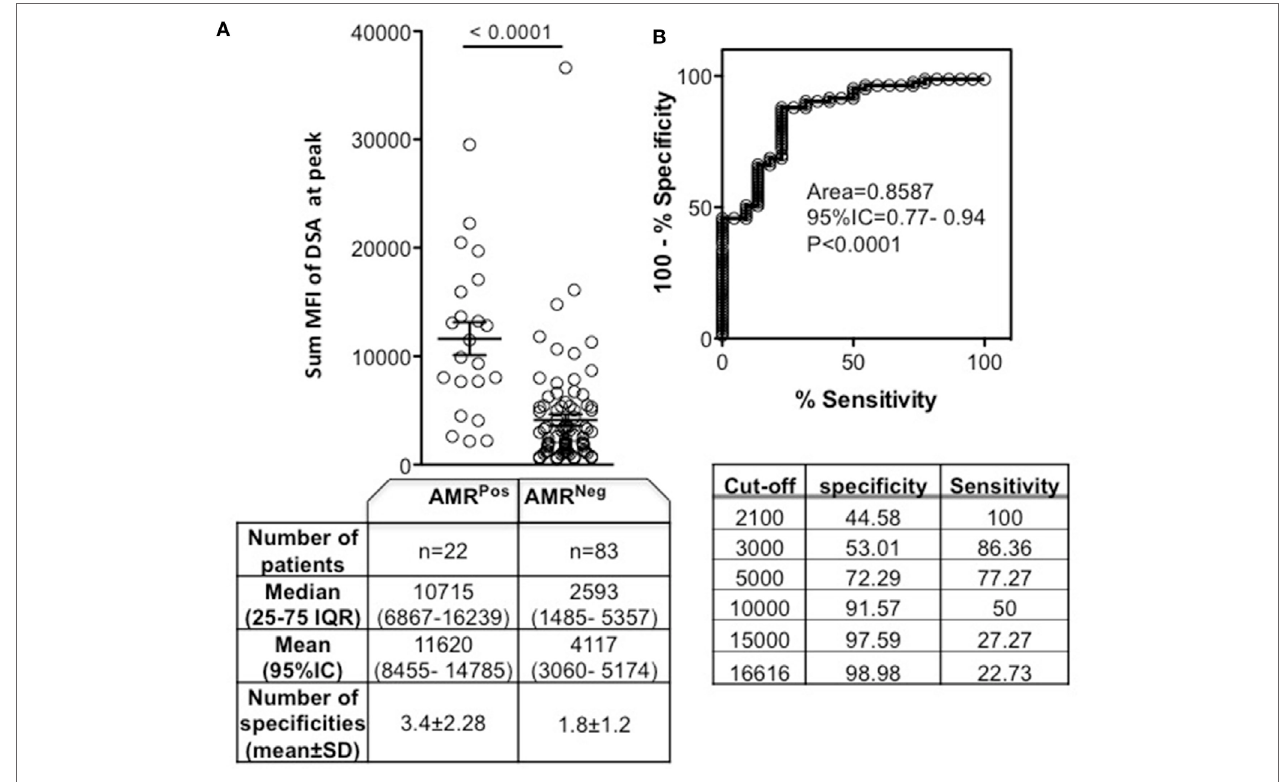
FigUre 3 | Sum mean fluorescence intensity (MFI) of donor specific antibody (DSA) at peak according to antibody-mediated rejection (AMR) status. Peak was defined as the time point of DSA with the highest sum MFI for AMR Neg (DSA Pos AMR Neg ) patients, or as the time of AMR diagnosis for AMR Pos patients. (a) The sum MFI of each patient’s DSA is indicated by each circle. The table below lists the number of patients, median and mean sum MFI, and number of specificities for each patient group. (b) ROC curve for use of sum MFI as a predictor of AMR diagnosis and the specificity/sensitivity according to MFI different cutoffs. Significance values are denoted above lines over compared